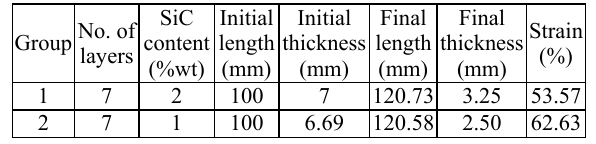
Table 2. Geometrical specifications of fabricated metal matrix